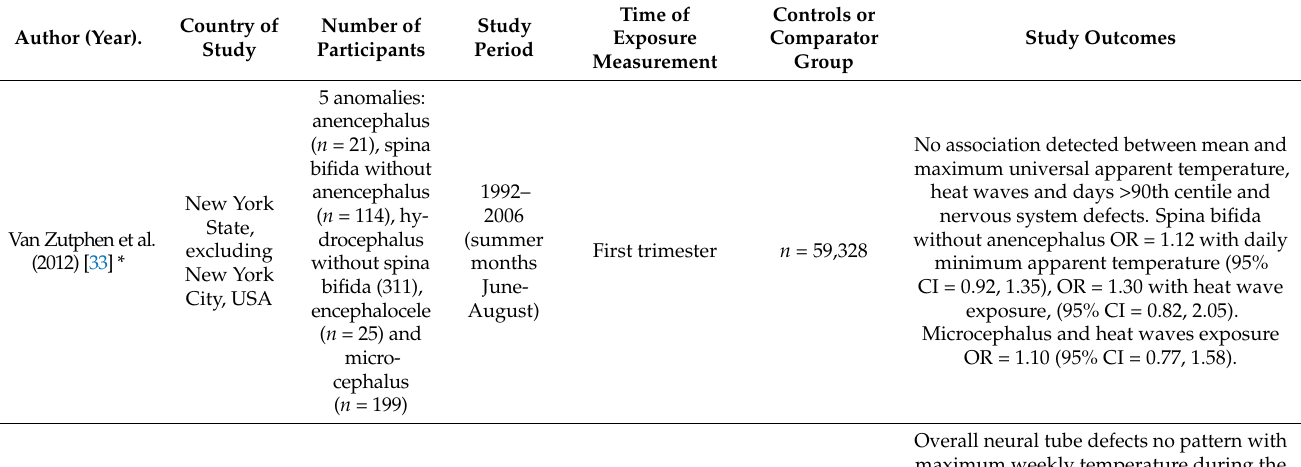
Table 2. Associations between heat exposure and neural tube